Question: Which visualization type does this figure use?
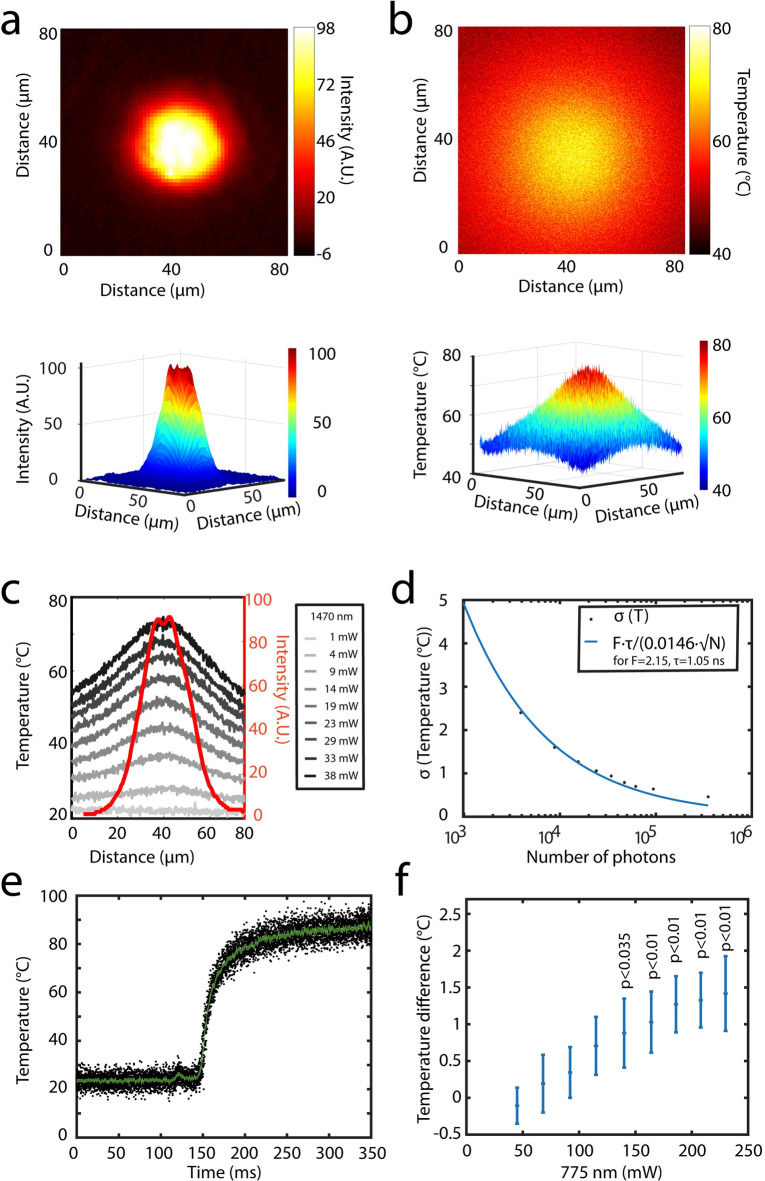
Answer: line